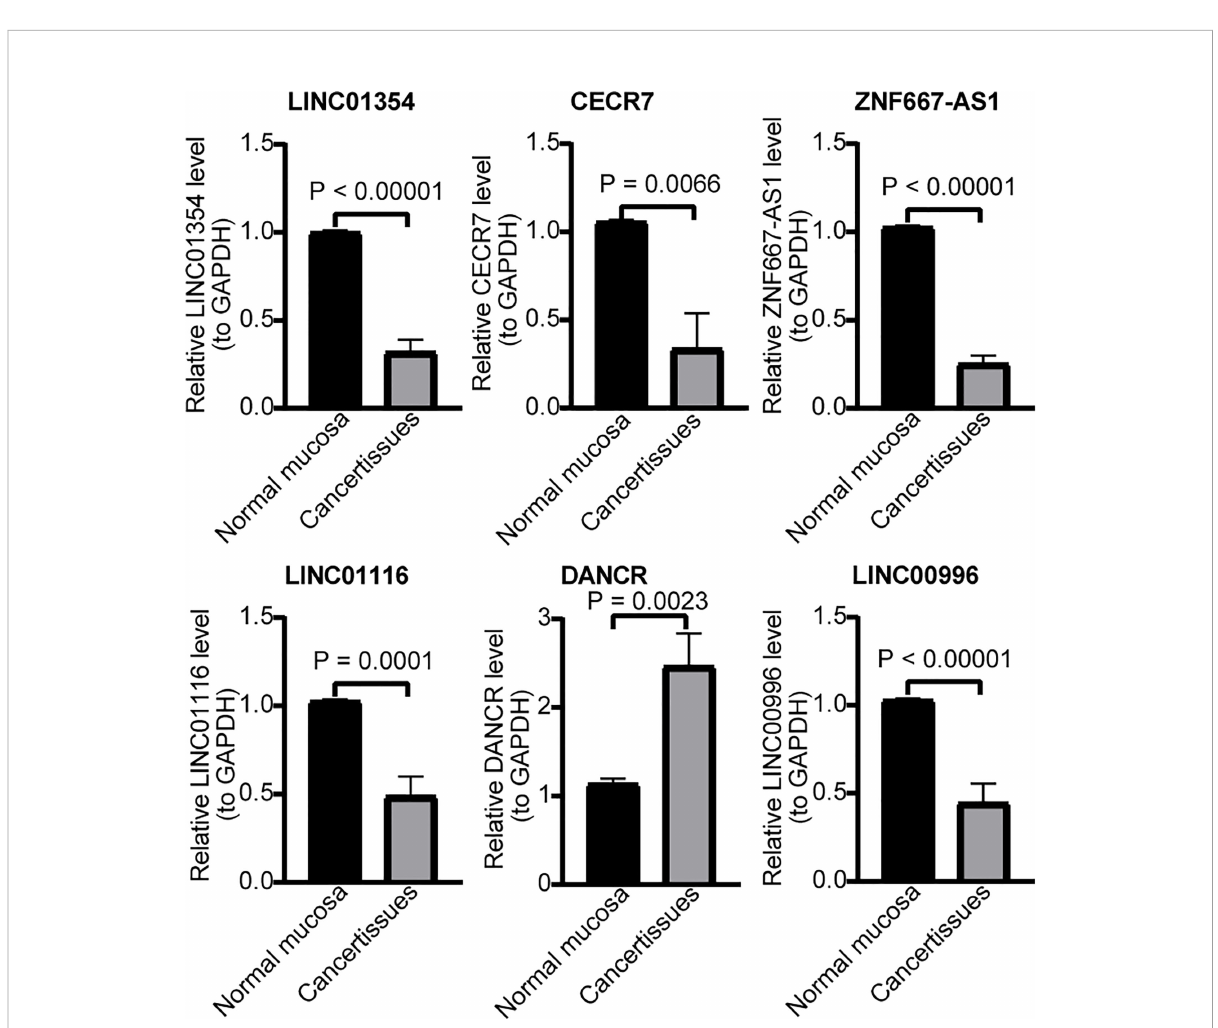
FIGURE 10 RT-qPCR validation for hypoxia-immune – related genes. Expression of LINC01354, CECR7, ZNF667-AS1, LINC01116, DANCR, and LINC00996 in CRC and normal mucosa